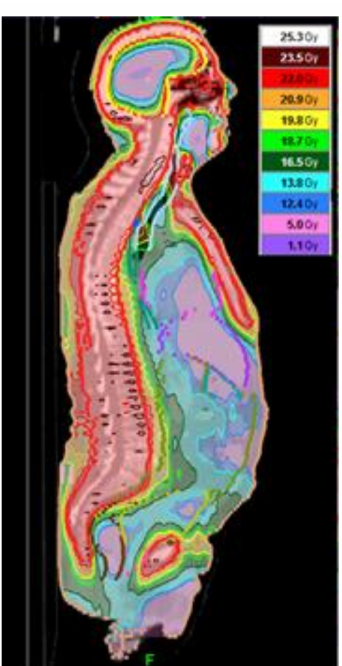
Figure 2. Isodose distribution demonstrating the ability to deliver variable doses of radiation to specific organs with a TMI